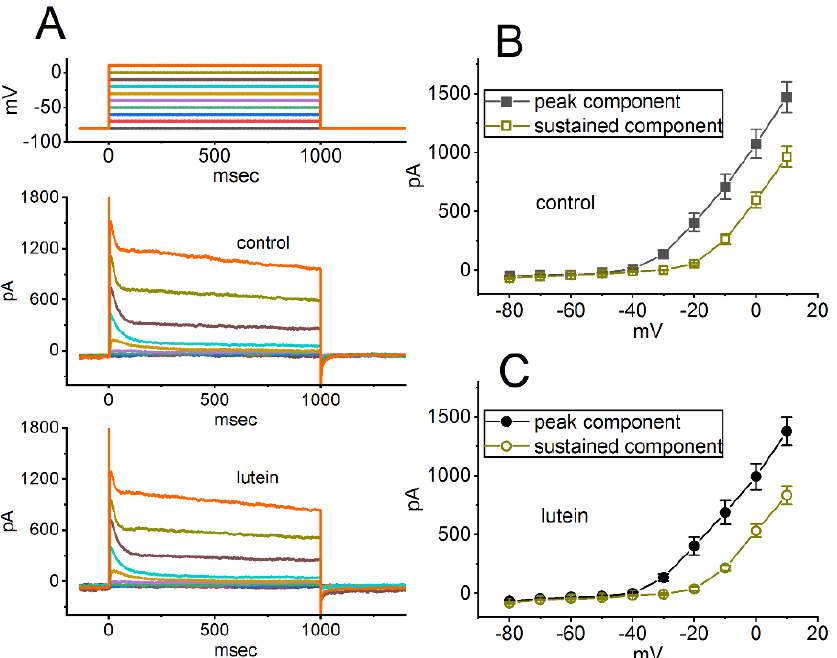
Figure 5. Effect of lutein on A-type K + current ( I K(A) ) identified from GH 3 cells. We conducted these experiments in cells bathed in Ca 2+ -free, Tyrode’s solution containing 1 μM TTX and 0.5 mM CdCl 2 , and the recording pipette was filled with K + -containing solution. ( A ) Superimposed current traces taken from the control period (i.e., lutein was not present; upper) and during exposure to 10 μM lutein (lower). The uppermost part indicates the voltage-clamp protocol imposed over the cell. The potential trace shown in different colors corresponds to the current one evoked by each membrane voltage. In ( B , C ), average I – V relationships of I K(A) in the absence ( B ) and presence ( C ) of 10 μM lutein were demonstrated, respectively. The peak (filled black squares or circles) and sustained (open brown squares or circles) components of I K(A) in ( B , C ) were respectively measured at the beginning and end of each voltage step. Each point represents the mean ± SEM ( n = 7 for each point).